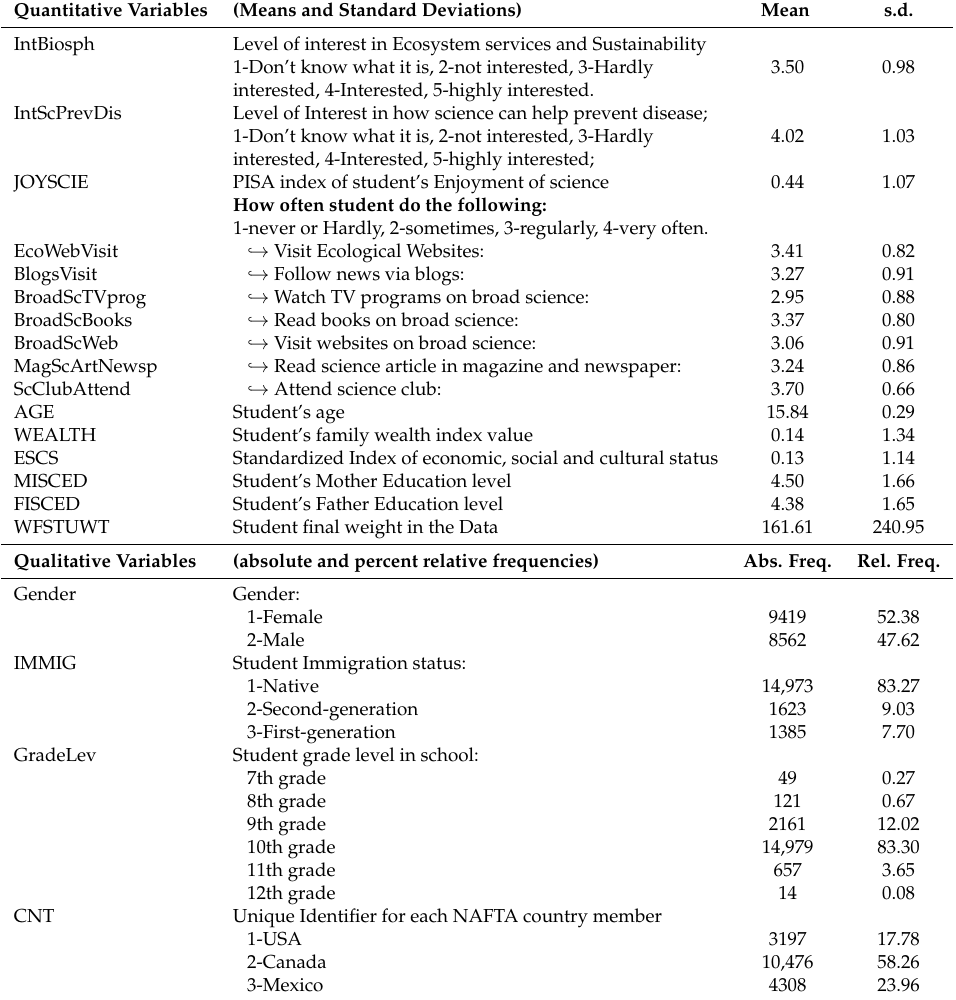
Table A1. Summary Description of the Variables used in the Econometric Modeling (N = 17,981). Quantitative Variables